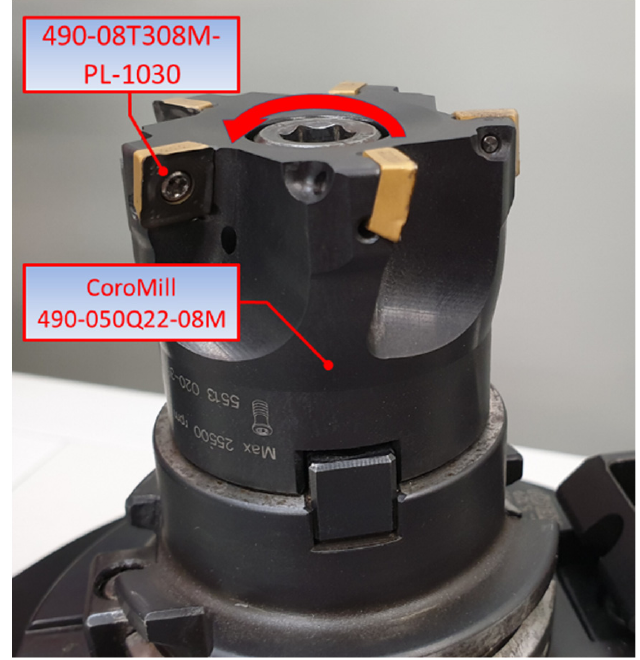
Figure 2. View of the CoroMill 490-050Q22-08M head by Sandvik Coromant.